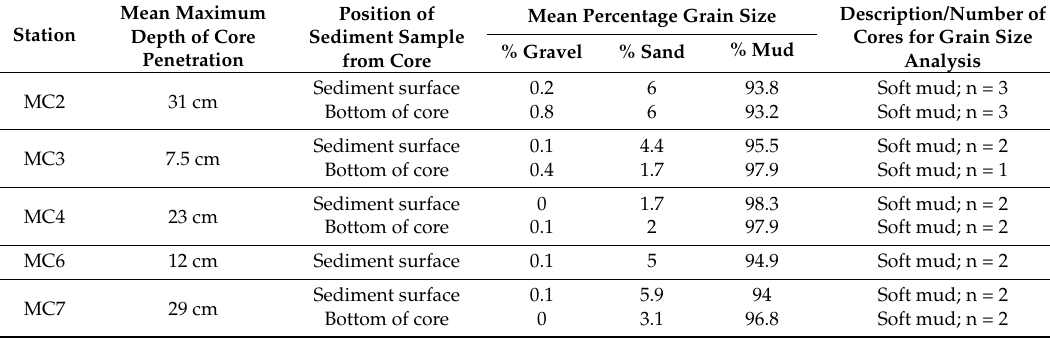
Table 3. Seafloor sediment information from the multicore